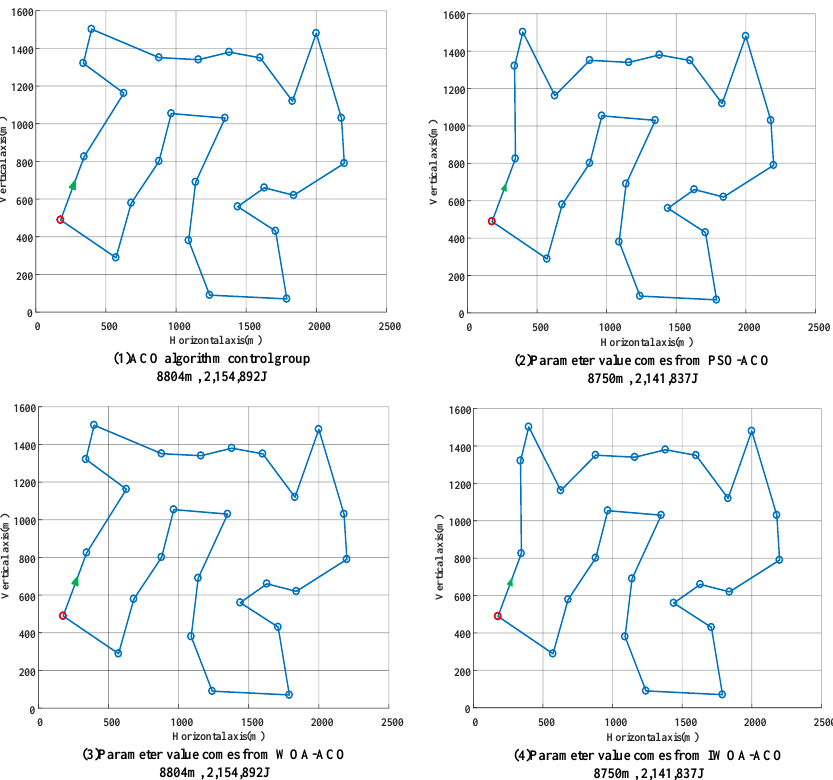
Figure 9. Path planning diagram in the simulation of flat environment. The red node is the starting point, and the green arrow is the travel direction of the electric tractor.